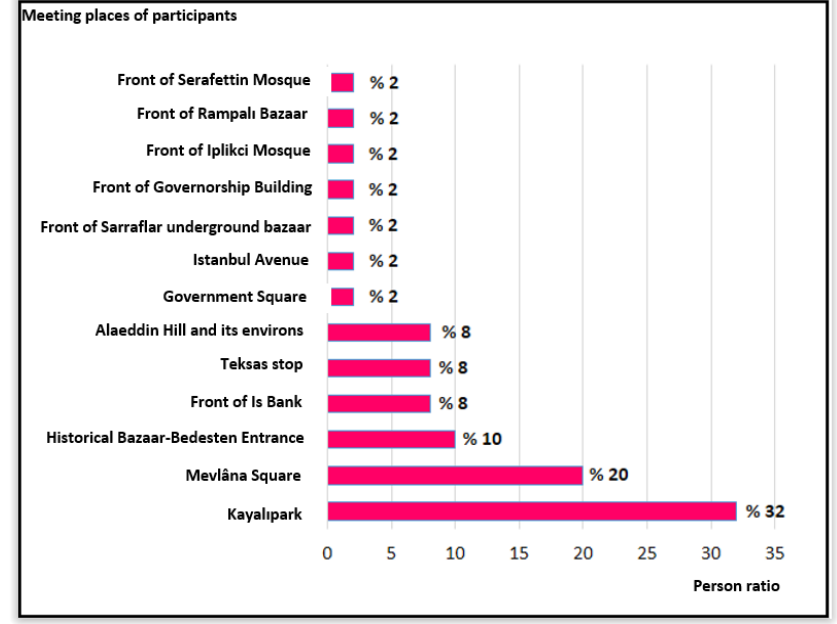
Figure 16 Meeting points frequently used by the participants in the area (Ünal,